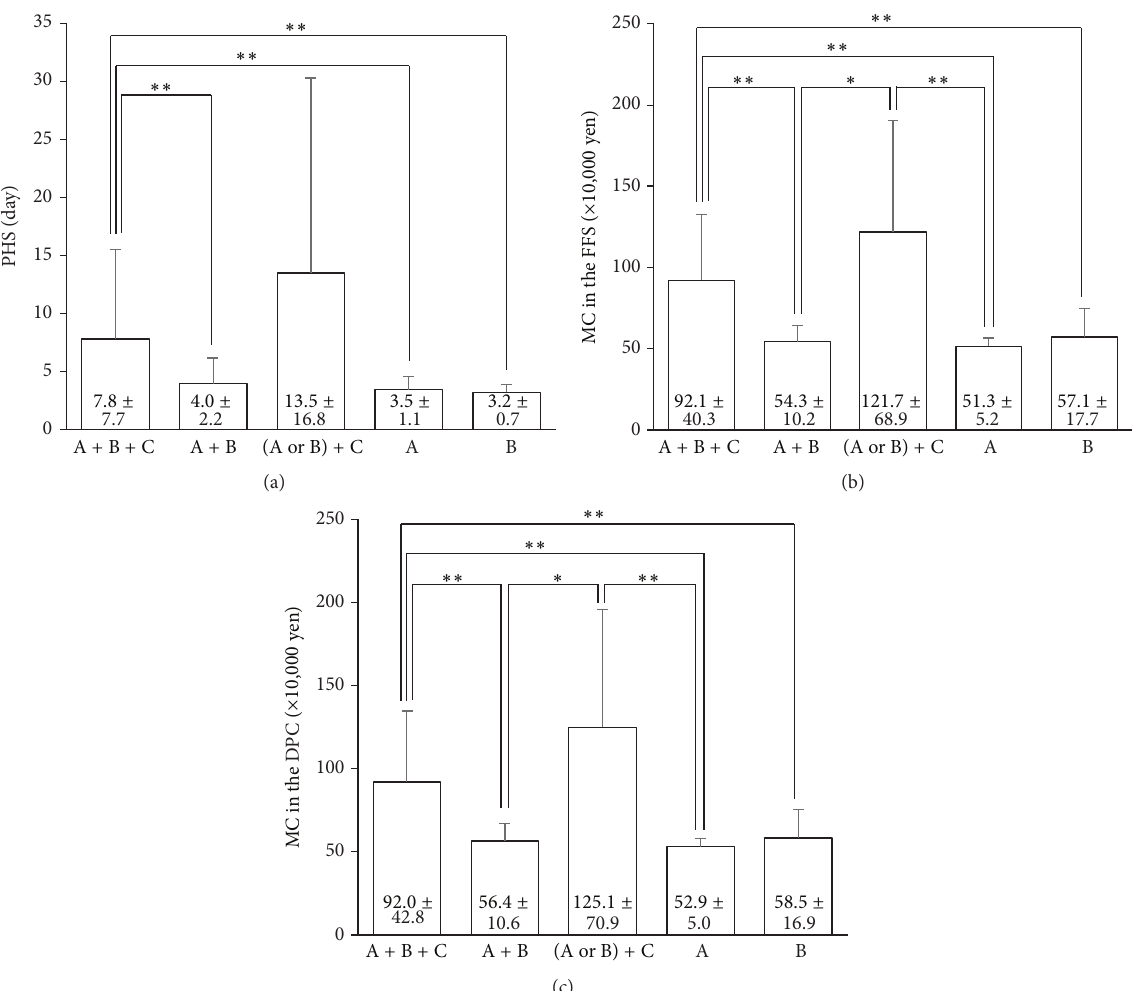
Figure 2: Comparison of PHS and MC in the FFS and DPC systems according to the five groups ( 𝑛 = 171 ). (a) The differences in the average PHS for each group. (b) The differences in the average MC in the FFS system for each group. (c) The differences in the average MC in the DPC system for each group. PHS: postoperative hospital stay, MC: medical costs, FFS: fee for service, and DPC: diagnosis procedure combination. ∗∗ 𝑃 < 0.01 and ∗ 𝑃 < 0.05 .